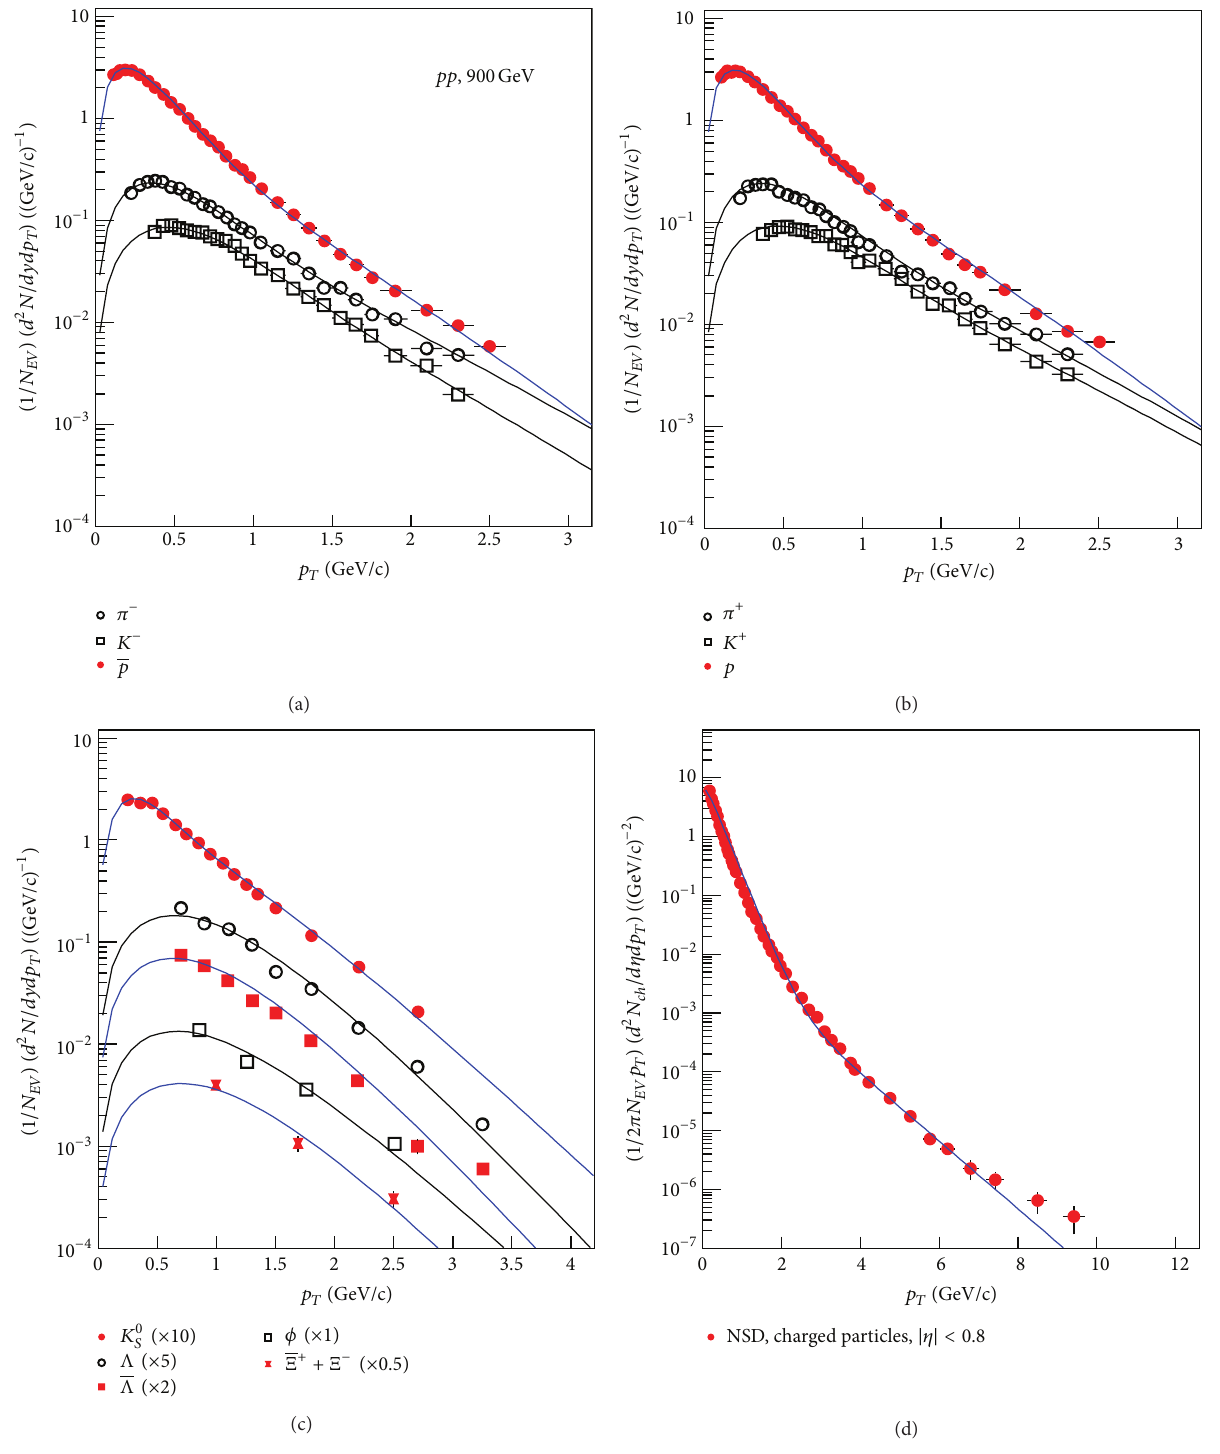
+ + Ξ − , and (d) charged